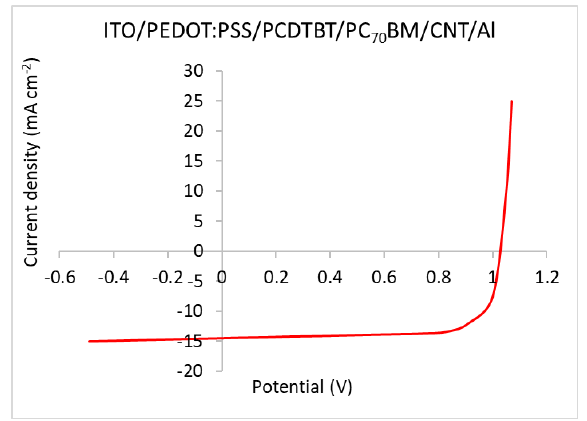
Figure 7. J – V plot for the ITO/PEDOT:PSS/PCDTBT/PC 70 BM/CNT/Al PV cell, where all layers were fabricated via casting, accompanied by cell annealing in dichlorobenzene vapor for 1 h at 80 °C and under the presence of transverse AC field.